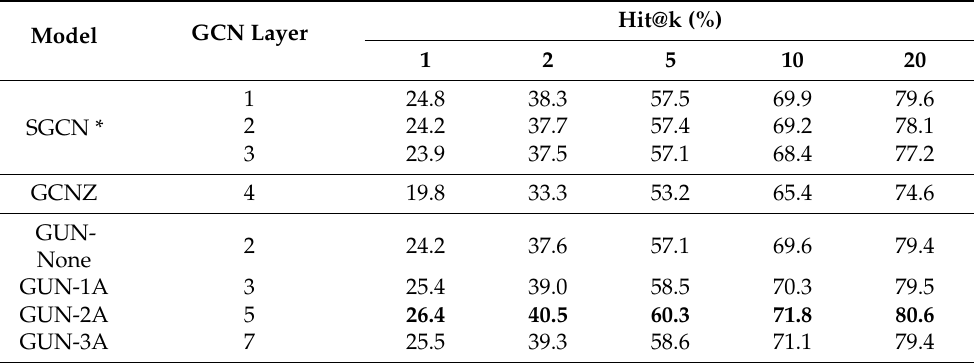
Table 5. Results for 2-hops for the model with different depths. Model GCN